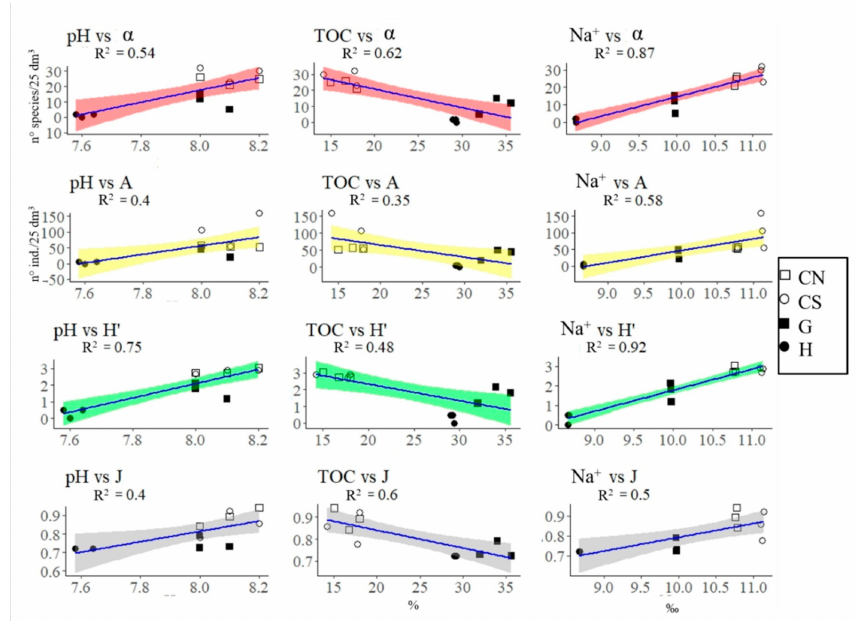
Figure 3. Linear regression models between environmental parameters (independent variables) and synecological indices (dependent variable) of Mollusca assemblages. In red—relations among environmental variables and α -diversity ( α ); in yellow—relations among environmental variables and abundances (A); in green—relations among environmental variables and diversity index (H’); in grey—relations among environmental variables and evenness (J). Significant R 2 is also shown for each